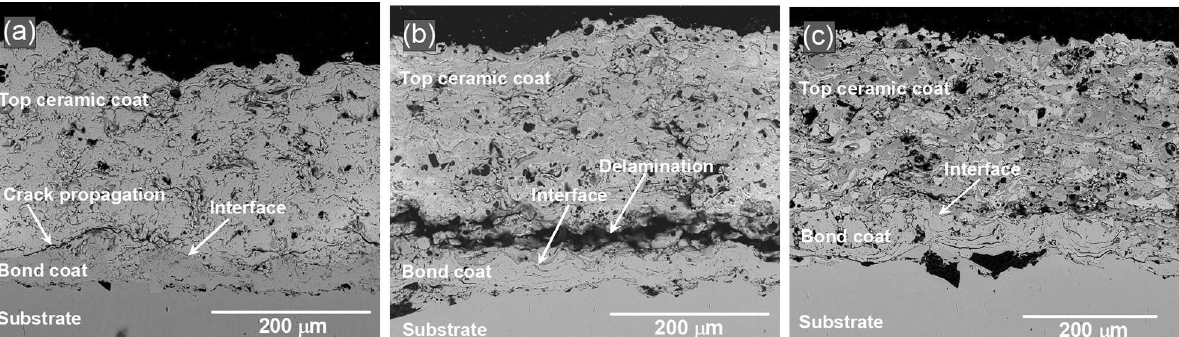
Figure 6. Cross-sectional SEM images showing crack propagation and coating delamination of as-sprayed top coatings in ( a ) CSZ and ( b ) MSZ, respectively. ( c ) Shows adherent interface between the Ni–5Al bond coat and the top ceramic CSZ-MSZ mixed coating. Coated samples of ZC3, ZM3, and Mix3 in ( a ), ( b ), and ( c ), respectively, were performed on the 304 stainless steel substrate at plasma current of 700